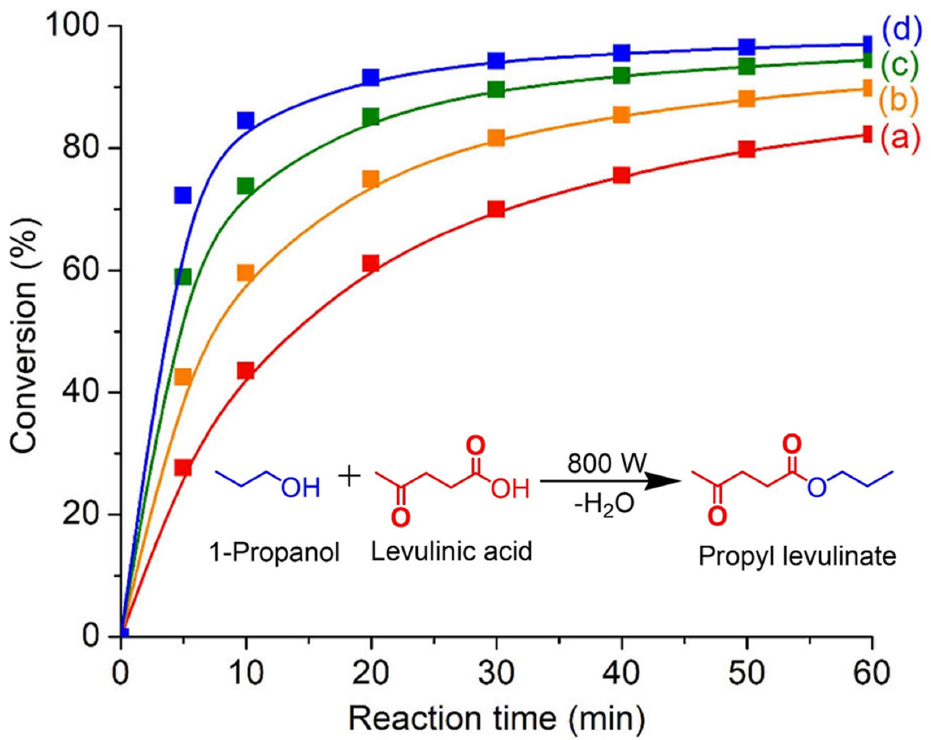
Figure 9. Microwave ‐ assisted esterification of levulinic acid with 1 ‐ propanol in the presence of Figure 9. Microwave-assisted esterification of levulinic acid with 1-propanol in the presence of SAPO ‐ 34 (S ‐ 3) catalyst at ( a ) 130 °C, ( b ) 150 °C, ( c ) 170 °C, and ( d ) 190 °C for 60 min. Reaction con ‐ SAPO-34 (S-3) catalyst at ( a ) 130 ◦ C, ( b ) 150 ◦ C, ( c ) 170 ◦ C, and ( d ) 190 ◦ C for 60 min. Reaction ditions: Catalyst loading = 0.100 g; 1 ‐ propanol:levulinic acid molar ratio = 11:1; microwave power = conditions: Catalyst loading = 0.100 g; 1-propanol:levulinic acid molar ratio = 11:1; microwave 800 W; solvent ‐ free. power = 800 W;